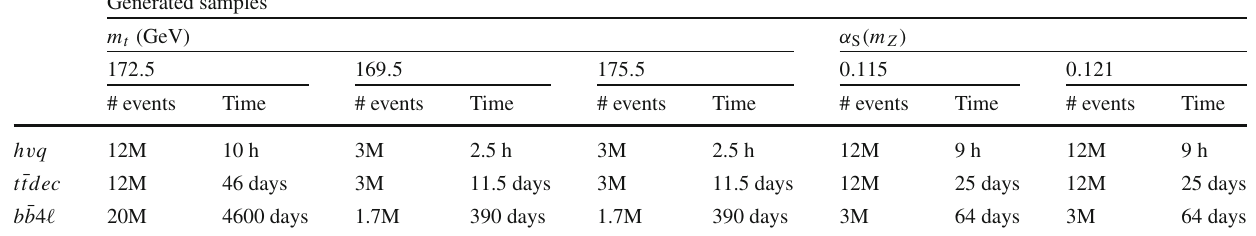
Table 1 Number of events and total CPU time of the generated sam- ples.Thesamplesusedforthe α S variationswereobtainedinarelatively smaller time, since in this case only the central weight was computed.